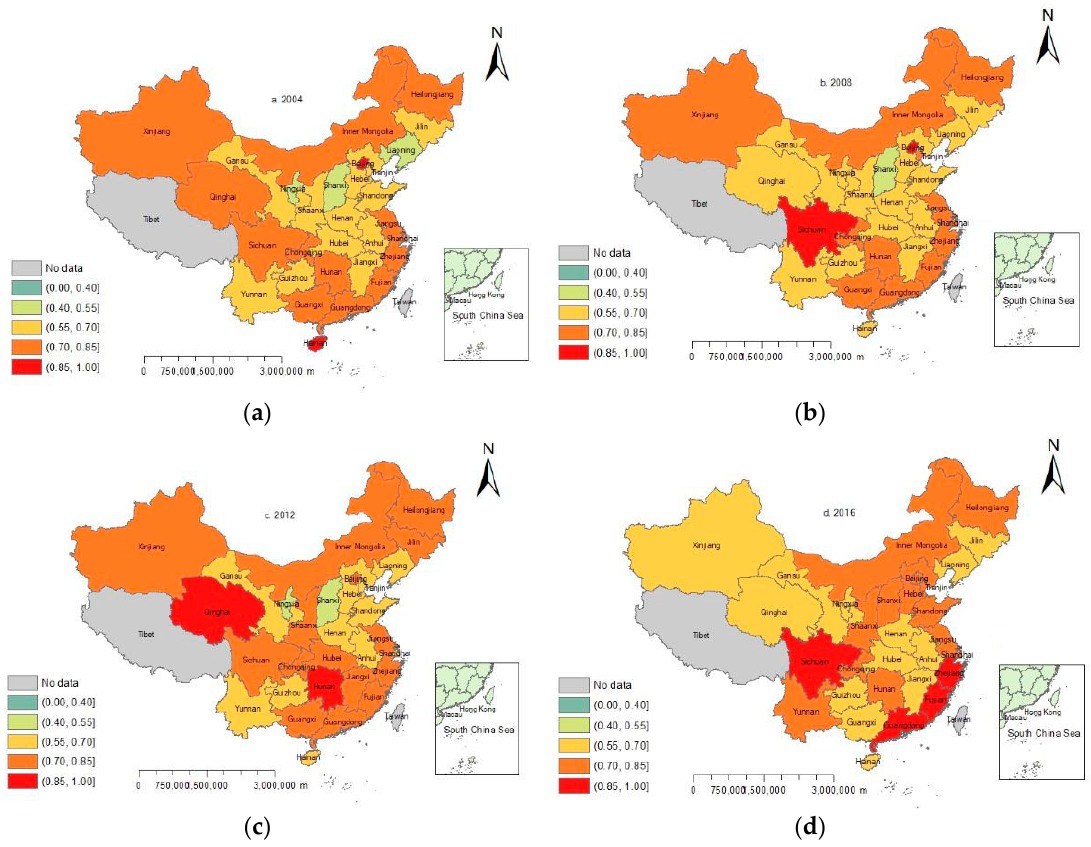
Figure 1. Spatial distribution of eco-efficiency of China in ( a ) 2004, ( b ) 2008, ( c ) 2012, and ( d )